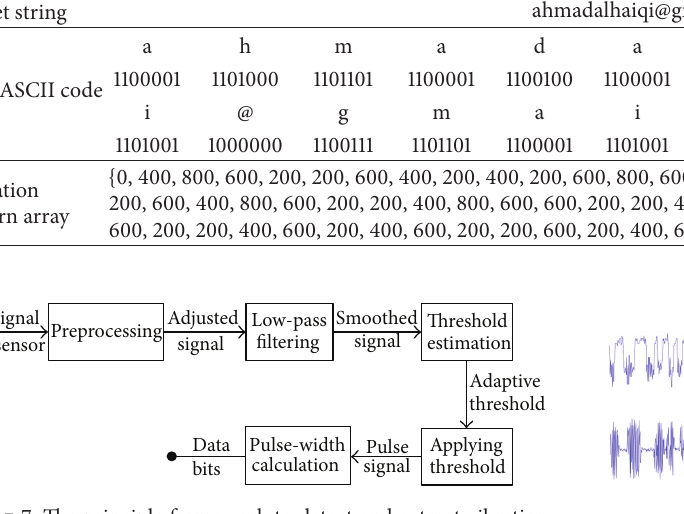
Figure 7: The principle framework to detect and extract vibration patterns and subsequently the hidden message bits from raw accelerometer data.